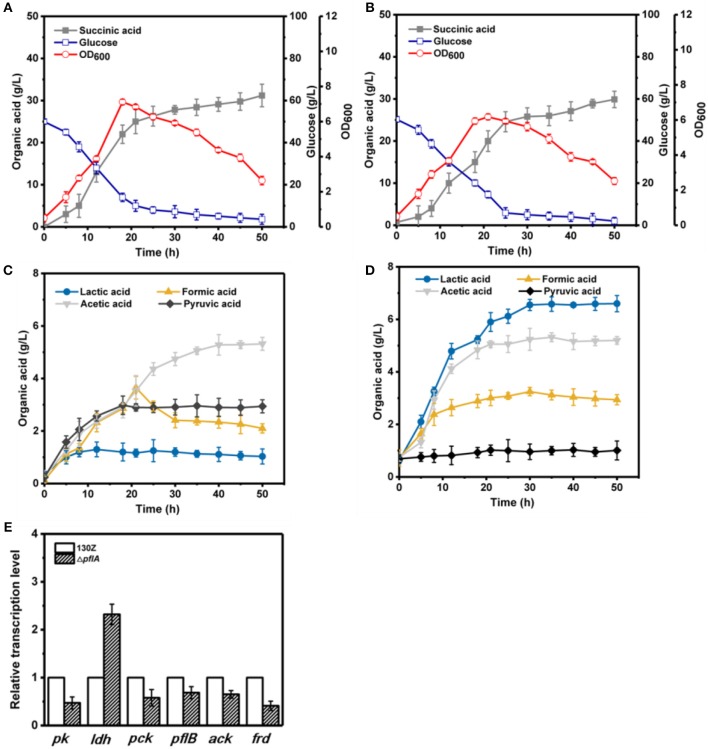
Evaluation of different fermentation and metabolic parameters in wild-type A. succinogenes 130Z (A,C) compared to those of the ΔpflA strain (B,D) under anaerobic conditions. The bar graph (E) represents the expression levels of genes related to organic acid biosynthesis pathway.